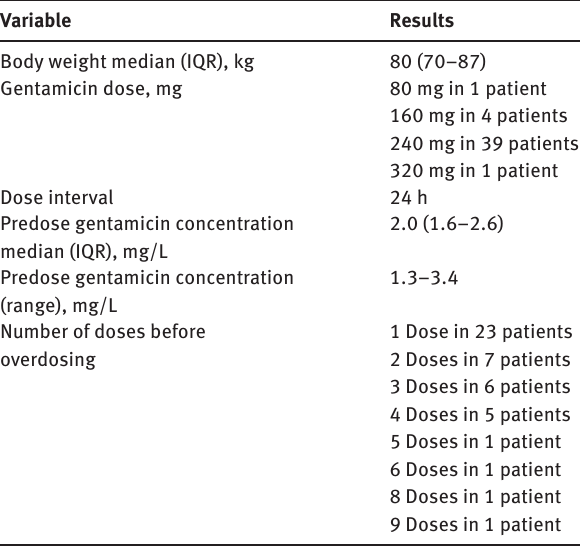
Table 1: The pharmacokinetic parameters of overdosed